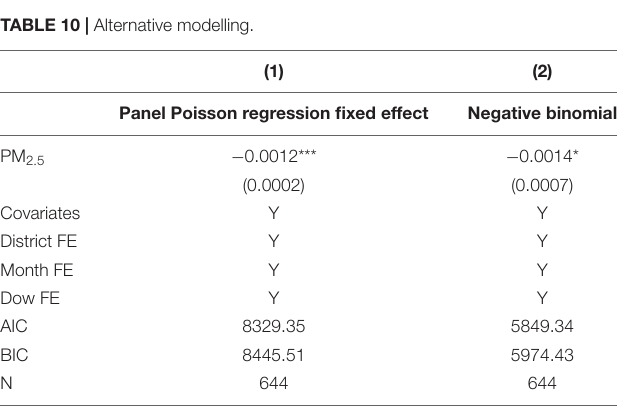
TABLE 10 | Alternative modelling. (1)